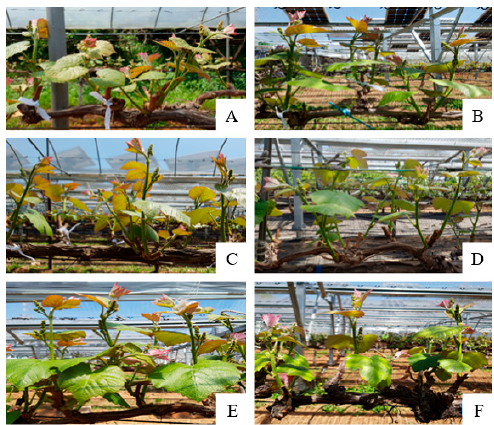
Figure 21. Development changes of grape flower gardens (6 May 2019). ( A ) Normal control site, ( B ) normal solar-panel site, ( C ) bifacial control site, ( D ) bifacial solar-panel site, ( E ) transparent control site, and ( F ) transparent solar-panel site. Energies 2020 , 13 , x FOR PEER REVIEW 15 of 19